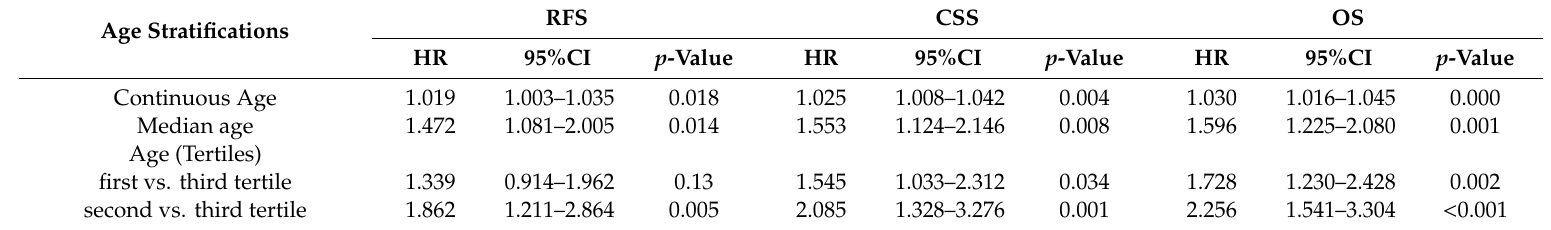
Table 3. Multivariable cox regression analysis of the e ff ect of age on predicting recurrence-free survival, cancer-specific survival and overall survival of 669 patients with UCB and treated with radical